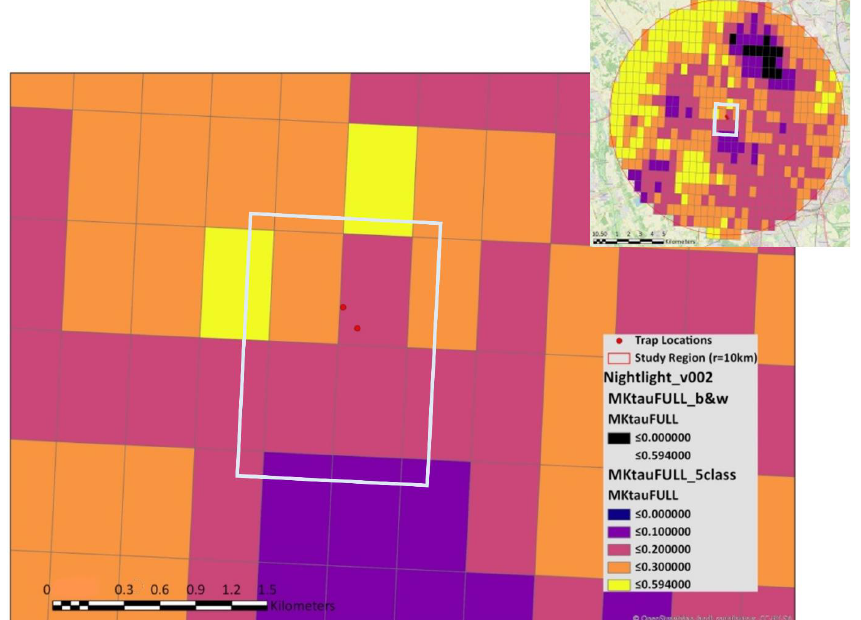
Figure A3. Mann-Kendall tau statistic values for pixels within a 1 km radius of the insect trap locations in Orbroicher Bruch Nature Preserve, with minimal changes in nightlight intensity occurring within the pixel containing the insect trap locations.